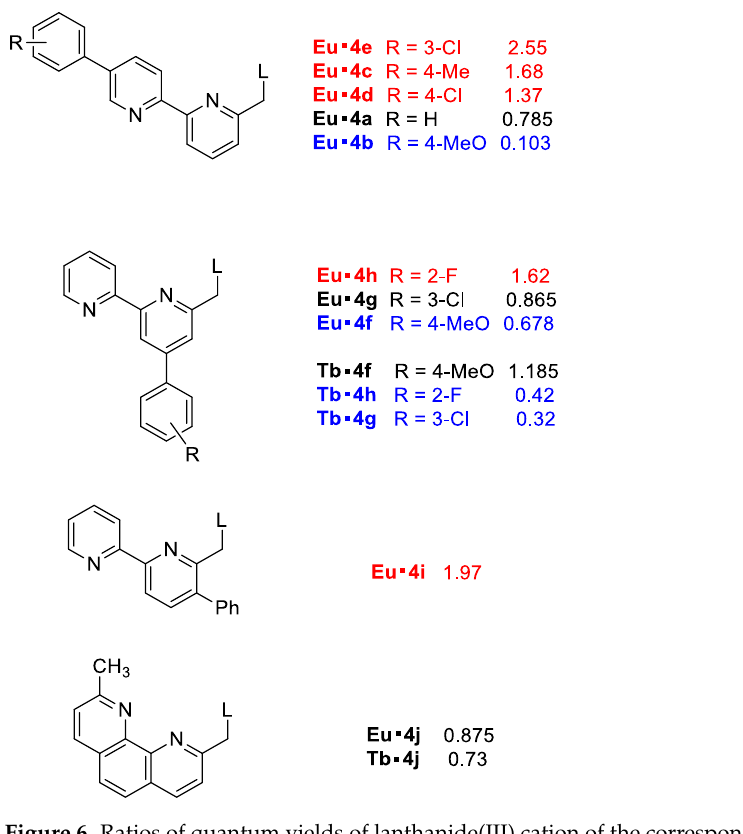
Figure 6. Ratios of quantum yields of lanthanide(III) cation of the corresponding complexes based on DO3A- and DTTA-appended ligands.